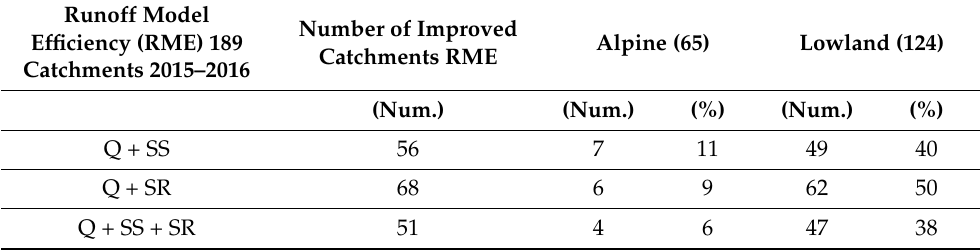
Table 7. The number/percentage of improved Alpine and Lowland catchments in the RMEs in the validation period